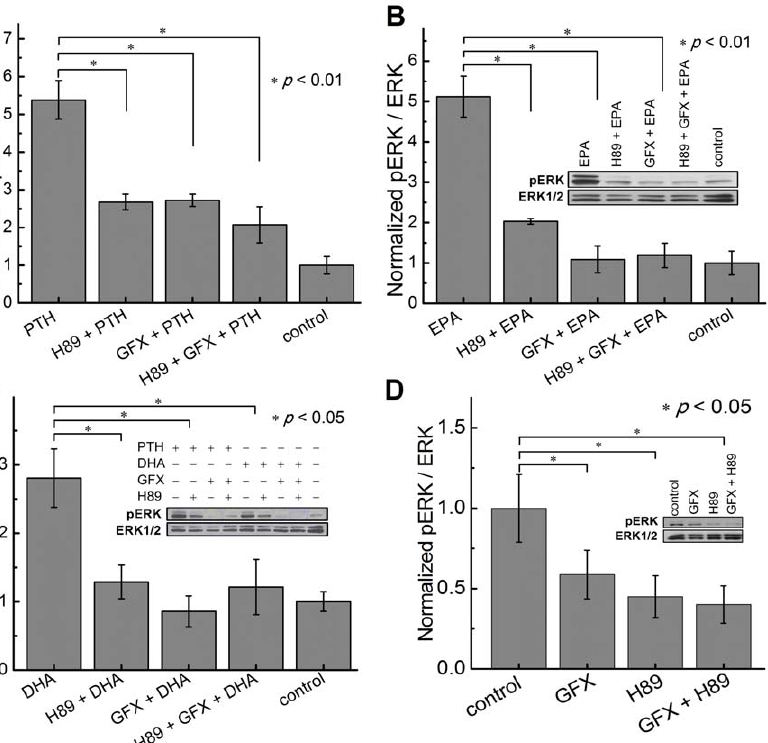
Figure 4. Inhibition of PKA or PKC reduces PTH or fatty acid-stimulated ERK1/2 phosphorylation. (A) HEK293 cells transfected with PTH1R and stimulated with PTH(1–34) (100 nM) for 5 minutes in the absence or presence of H-89 (20 m M), GFX (2.5 m M) or both. Cells were pretreated with inhibitors for 15 minutes. (B) Cells were stimulated with 10 m M EPA. (C) Cells were stimulated with 10 m M DHA. (D) PTH1R transfected cells in the presence of H-89, GFX or both. Values are expressed as ratio of pERK to ERK1/2 after 5 minute stimulation. Data represents the mean from at least three independent experiments.